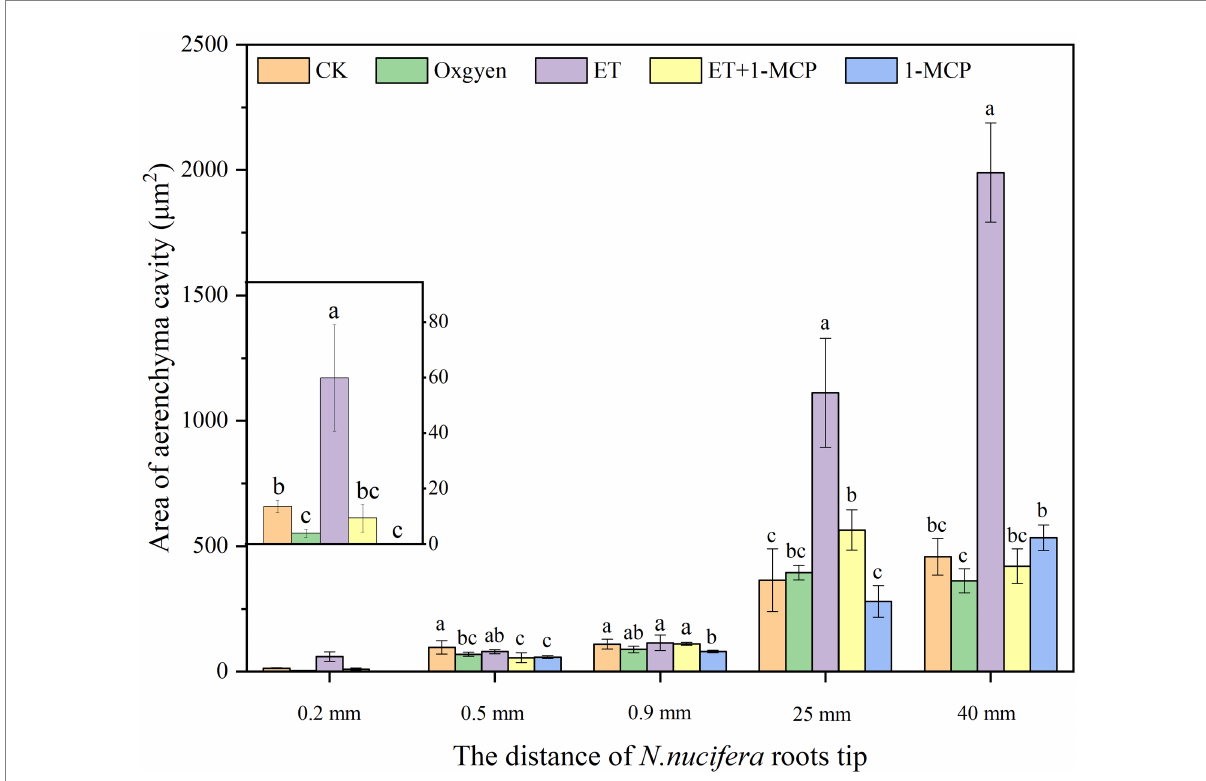
FIGURE 8 Effects of oxygen and ET on aerenchyma area in Nelumbo nucifera roots. Nelumbo nucifera roots at 0.2, 0.5, 0.9, 25, and 40 mm from the root tip were selected, representing the early formation stage, middle formation stage, late formation stage, expansion stage, and mature stage of aerenchyma, respectively. With a normal water environment as the *control, aerenchyma development after continuous aeration of 21% oxygen, adding ET and its inhibitor 1-MCP in an aquatic environment was observed, and the area of the first round of aerenchyma was counted. Values are mean ± SE ( n = 3). Lowercase letters indicate significant differences between different treatments at the same sampling time ( p < 0.05). Control (CK), ethylene (ET), ET synthesis inhibitor (1-methylcyclopropene, 1-MCP). CK: unaerated water; Oxygen: 21% oxygen solution; ET: ET solution; ET + 1-MCP: ET + 1-MCP solution; and 1-MCP: 1-MCP